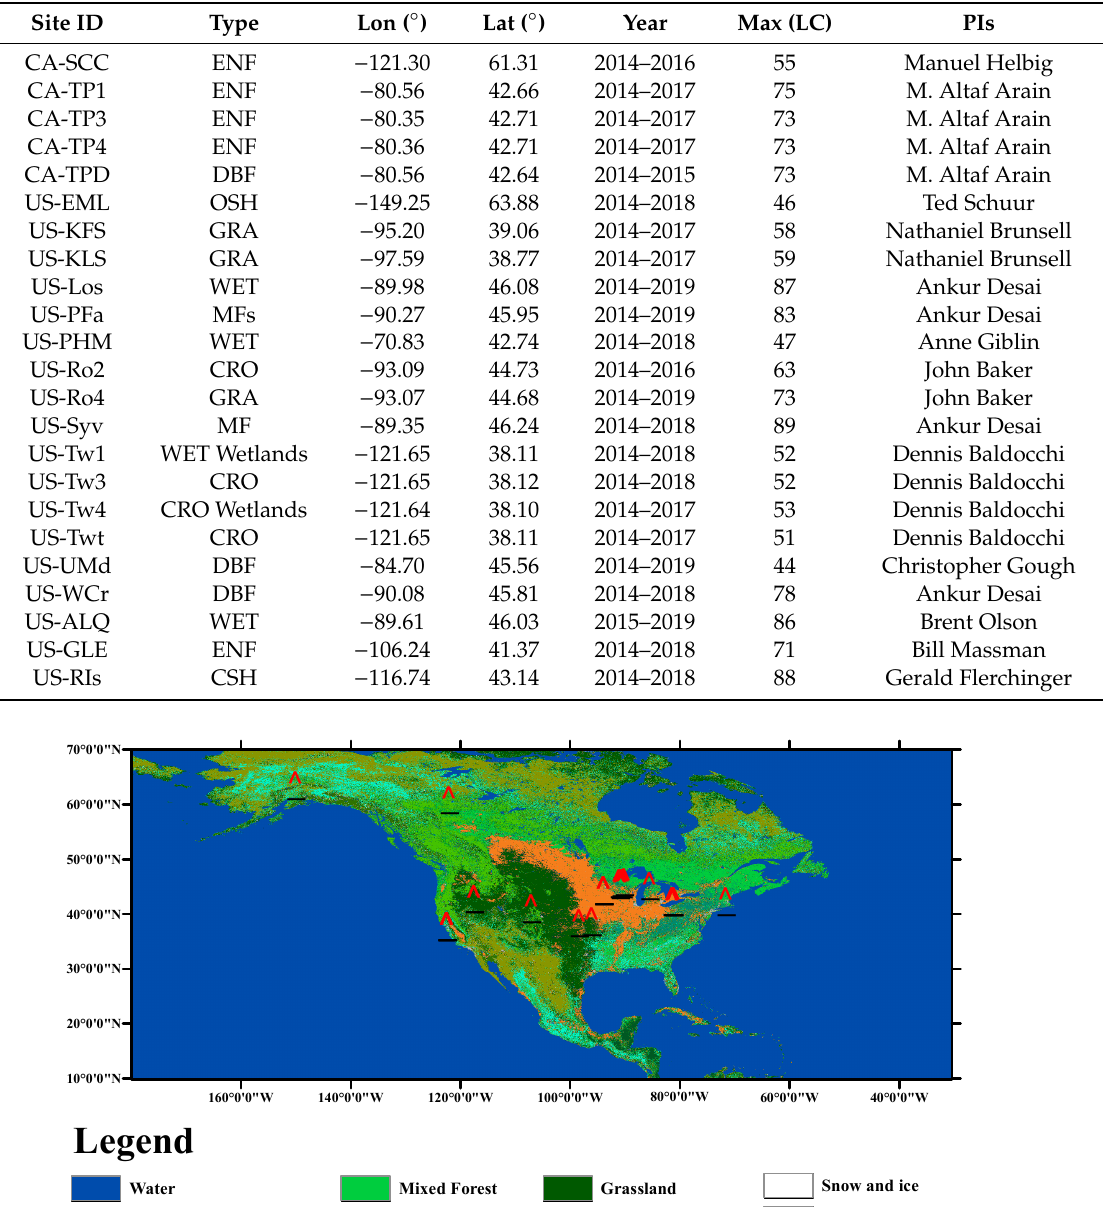
Table 1. Site descriptions of the flux towers, including the site ID, vegetation type, longitude, latitude, year the data was used, maximum land cover (Max(LC)), and flux tower principal investigators (PIs) of each flux tower (ENF: evergreen needleleaf forests, DBF: deciduous broadleaf forests, OSH: open shrublands, GRA: grasslands, CSH: closed shrublands, MF: mixed forests, WET: permeland wetlands, CRO: croplands).